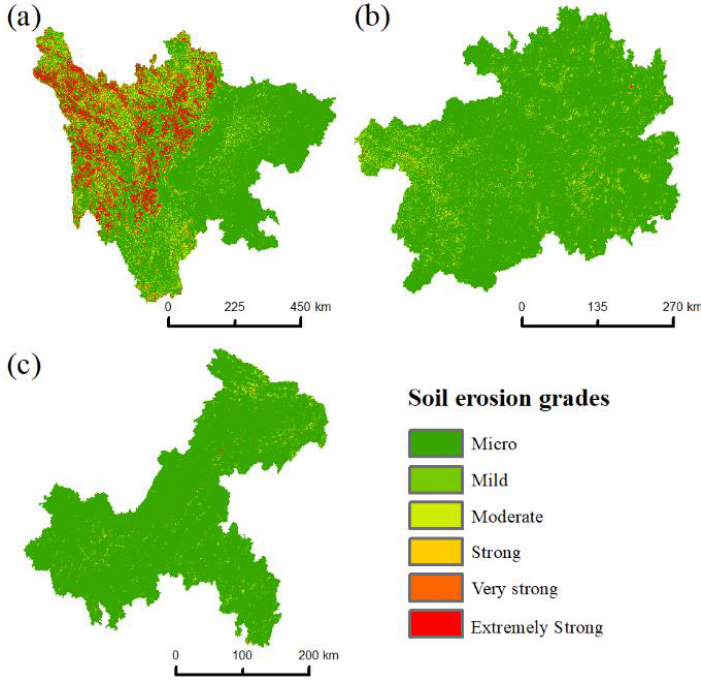
Figure 6. Distribution of soil erosion intensity in the study area. ( a ) Sichuan; ( b ) Guizhou; ( c ) Chongqing. Table 3. Area and proportion of each erosion intensity grade and erosion modulus in three